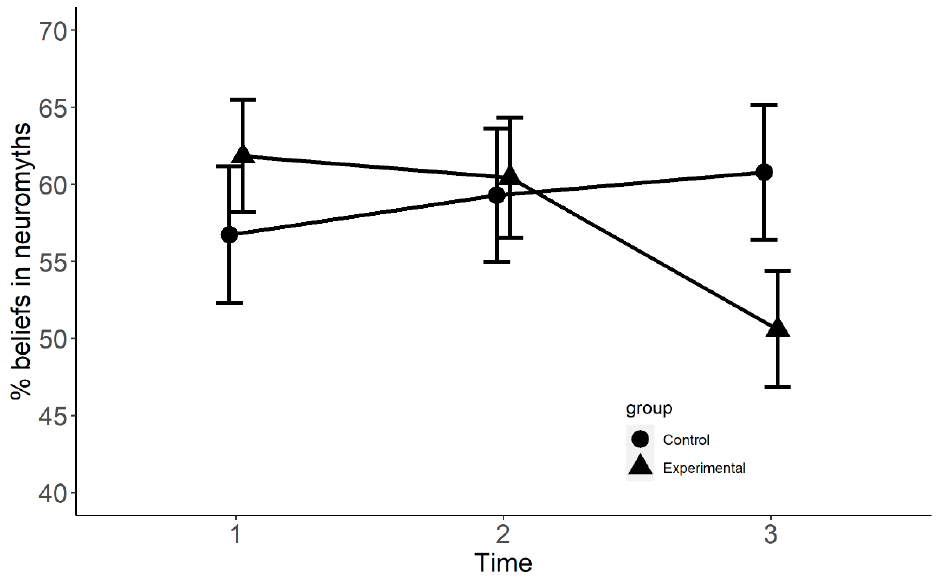
Figure 2 . Percent beliefs in neuromyths of control and experimental groups at Times 1, 2, and 3.